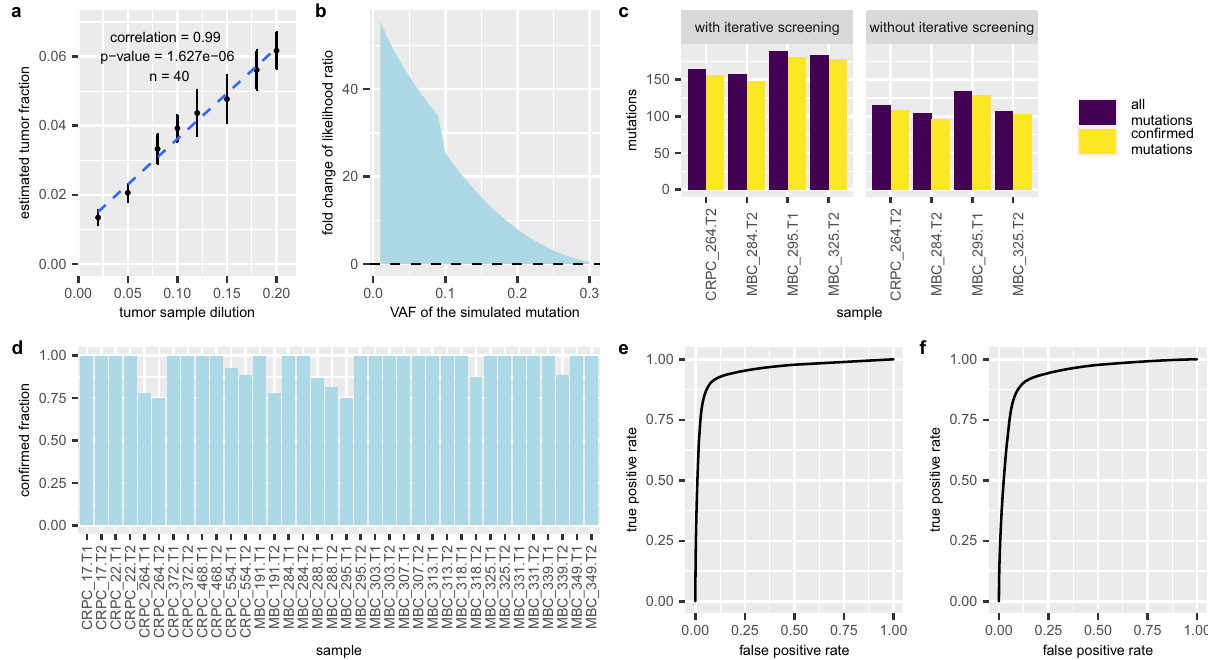
Fig. 4 Experimental analysis of fi ve techniques. a Performance of mutation cluster frequency estimation in terms of the correlation between the estimated tumor fraction and the true dilution ratio. This experiment uses simulated data based on WES of a single patient, with dilution ratios ranging from 2 to 20%. The points and the error bars are presented as mean ± s.d. of independently generated datasets ( n = 5) at each dilution. The p -value was calculated from two-sided Pearson ’ s correlation test: Pearson ’ s correlation = 0.99 (95% CI = [0.95, 1.00]), two-sided Pearson ’ s correlation test p -value = 1.627e − 06 ( t statistic = 9.1154, df = 57), n = 40. b the fold change in the likelihood ratio between cfSNV models with and without a step to estimate the mutation cluster frequency, based on simulated mutations at different VAFs. c Number of con fi rmed mutations and all mutations detected with and without the iterative classi fi er on independent testing data. e The averaged receiver operating characteristic curve (ROC) of applying the classi fi er to labeled data taken from 24 cfDNA sequencing samples of 12 metastatic breast cancer patients. f The averaged ROC of applying the classi fi er to labeled data taken from 12 cfDNA sequencing samples of 6 metastatic prostate cancer